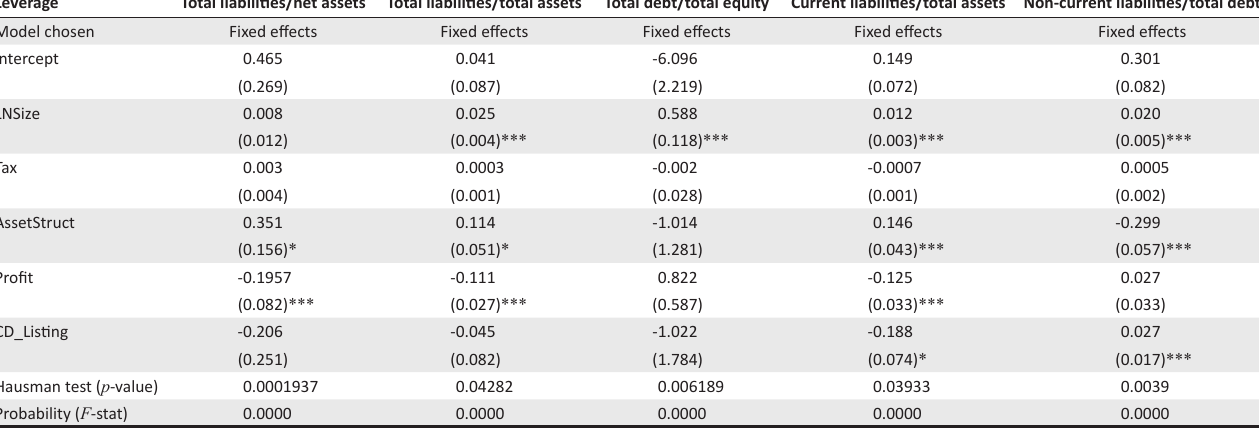
TABLE 9: Regression results: Eqn 1. Leverage